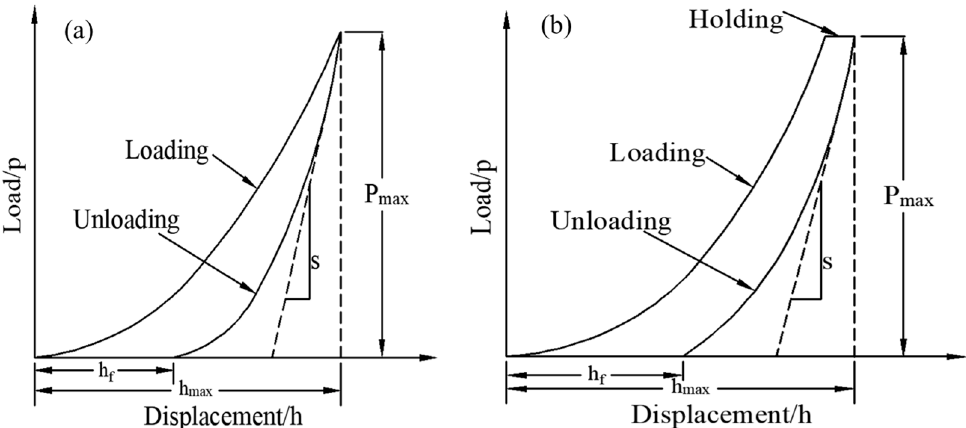
Figure 8. Typical load–displacement curve for nanoindentation: ( a ) curve with no load holding; ( b ) curve with load holding .